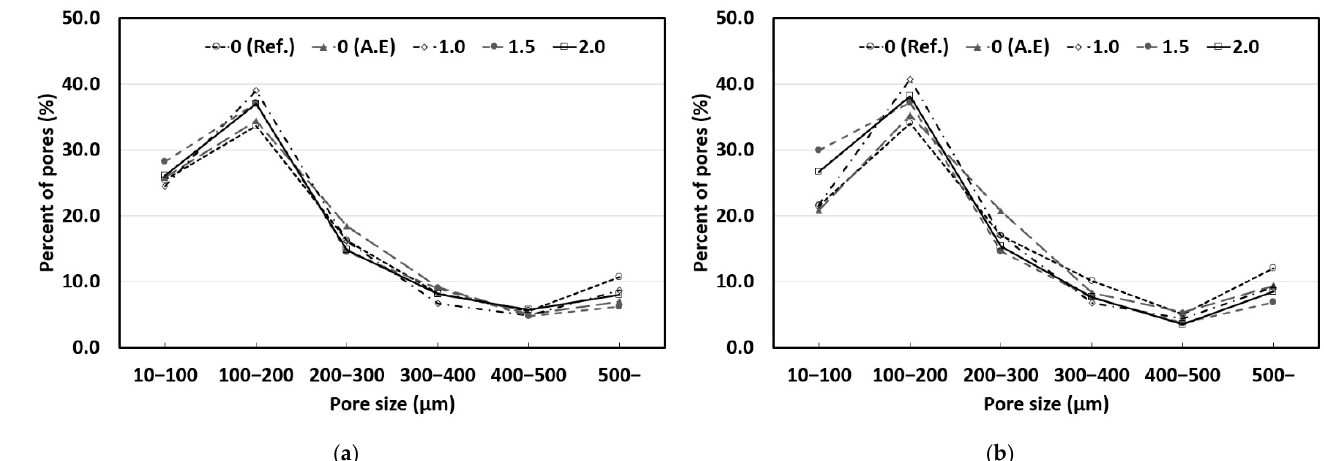
Figure 12. Results of pore size distribution (W/C 40%): ( a ) Sealed curing; ( b ) Water curing.